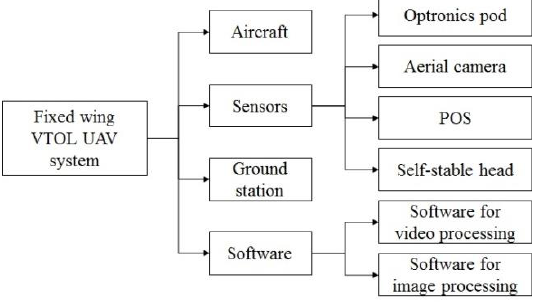
Figure 1. Major Components of fixed wing VTOL UAV system